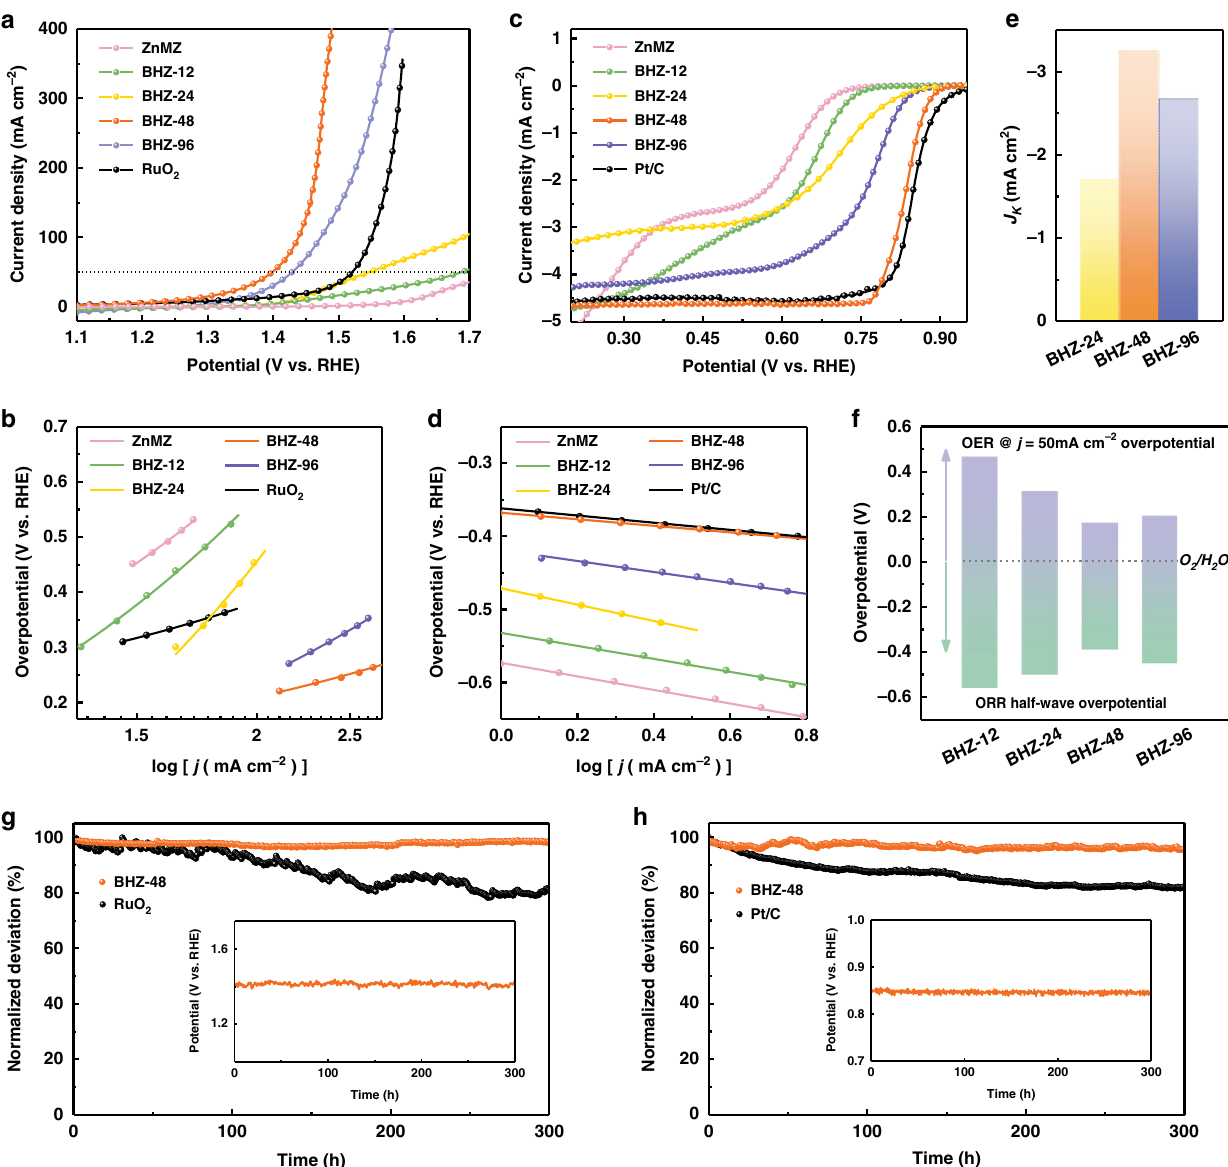
Fig. 3 Electrochemical behaviors in half-cell. a OER LSV curves, b OER Tafel plots comparison, c ORR LSV curves, d ORR Tafel plots comparison of samples in the BHZ series, commercial RuO 2 , and Pt/C. e Comparison of J K @ half-wave potential, f overpotential differences between the E half-wave of ORR and E j = 50 of OER for BHZ-48 and other products. g OER chronoamperometric response at a fi xed overpotential of 170 mV for BHZ-48 and 290 mV for RuO 2 , h ORR chronoamperometric response of BHZ-48 and Pt/C at a fi xed potential of 0.7 V vs. RHE. Inset: chronopotentiometric response at a constant anodic and cathodic current density for